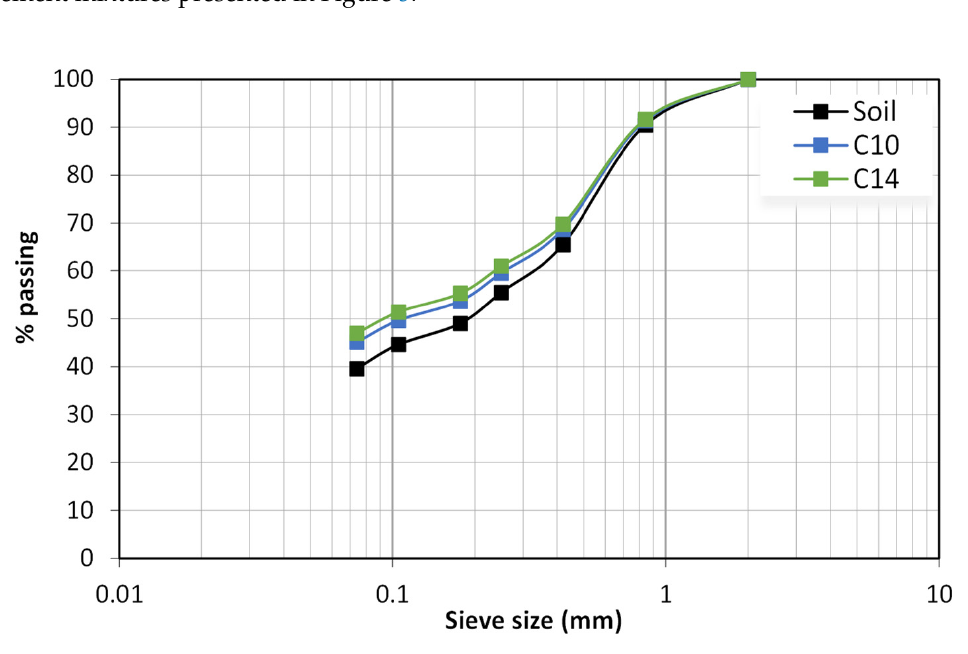
Table 3. Compaction of cement-bound soils.